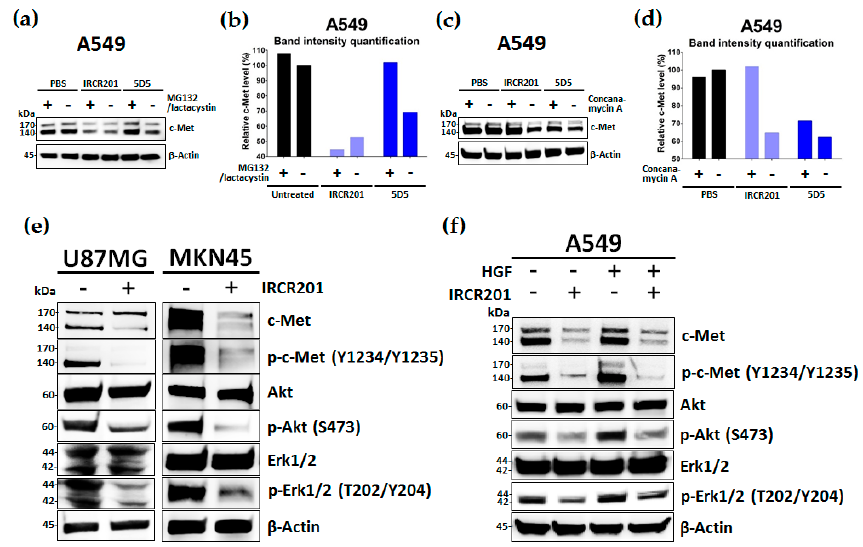
Figure 7. IRCR201 suppresses c-Met signaling pathway via the degradation of c-Met. ( a , b ) A549 cells were pre-treated with dimethyl sulfoxide (DMSO) or MG132 (5 µ M)/lactacystin (5 µ M) mixture for 2 h and incubated with 100 nM anti-c-Met antibodies (IRCR201 or 5D5) or phosphate-buffered saline (PBS). After 4 h of incubation, the c-Met degradation pattern was measured by Western blot analysis. The band intensities of c-Met were quantified by a Multi Gauge V3.0 program and normalized by the intensity of corresponding β -actin band; ( c , d ) A549 cells were pre-treated with DMSO or 100 nM concanamycin A for 2 h and subsequently treated with 100 nM anti-c-Met antibodies (IRCR201 or 5D5) or PBS for 4 h. The c-Met degradation pattern was evaluated by immunoblot analysis and analyzed by Multi Gauge V3.0 program; ( e ) Western blot analysis of c-Met, phospho-c-Met, Akt, phospho-Akt, Erk1/2, and phospho-Erk1/2 after 24-h treatment with IRCR201 (100 nM) or PBS in U87MG and MKN45; ( f ) Western blot analysis of c-Met, phospho-c-Met, Akt, phospho-Akt, Erk1/2, and phospho-Erk1/2 after 24-h treatment with IRCR201 (100 nM) or PBS in A549 in the presence or absence of HGF (50 ng/mL).